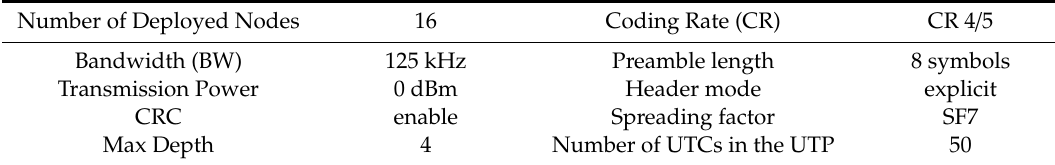
Figure 14. Nodes deployment in the scenario. ( a ) Nodes deployed in the Scenario; ( b ) LoRa node prototype. Table 2. Experiment Configuration